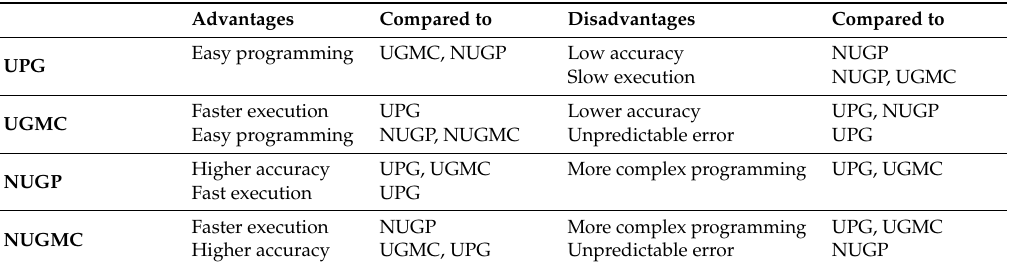
Table 9. Comparison of advantages and disadvantages of all four considered